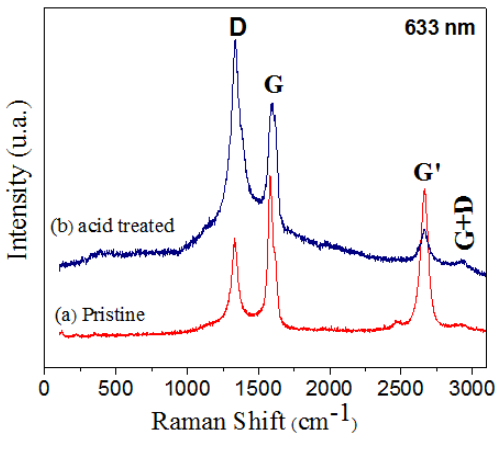
Figure 4. Raman spectrum of CNTs using a laser excitation of 633 nm, ( a ) pristine sample; and ( b ) acid